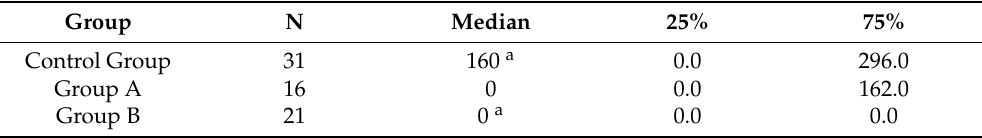
Table 4. Results of eosinophil counts (cell/ µ L) in all groups. Group